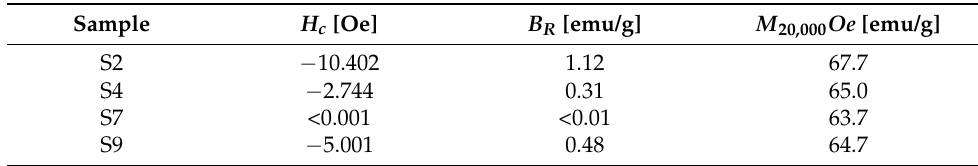
Table 6. H c , B R and magnetization at 20,000 Oe ( M 20,000 Oe ) external magnetic field recorded for the MION